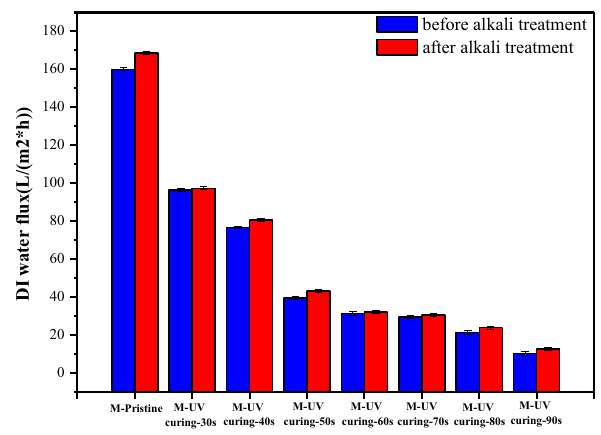
Fig. 10 The influence of alkali treatment on membrane pure water